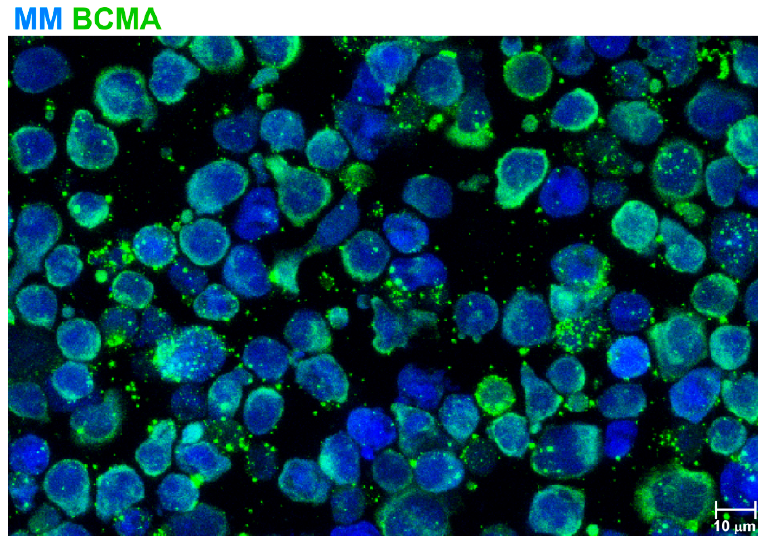
Figure 1. BCMA expression and release from multiple myeloma (MM) cells: MM cells (in blue) stained for BCMA (green). BCMA can be released in vesicles, and shows a non-uniform expression among all MM cells which changes over time. Scale bar is indicated.